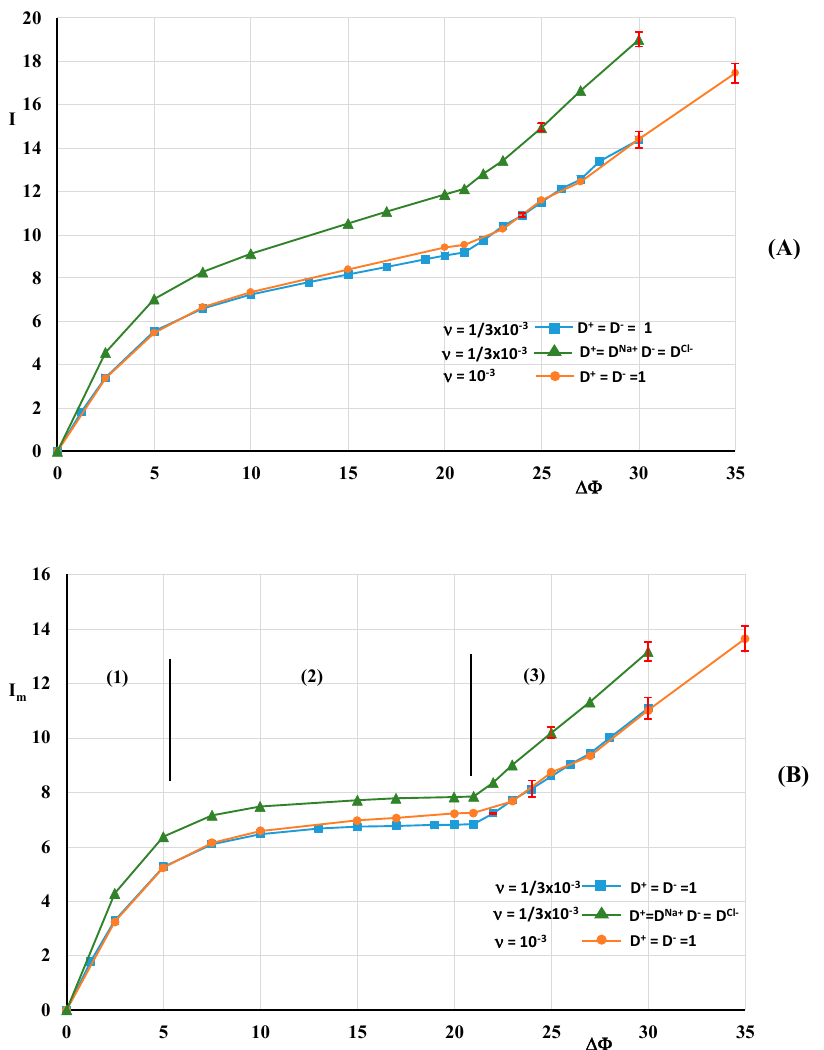
Figure 3. Current density vs. potential drop. ( A ): mean current density through the domain ( I ); ( B ): current density at the membrane surface ( I m ). The red vertical bars represent the variance of the current density signal.